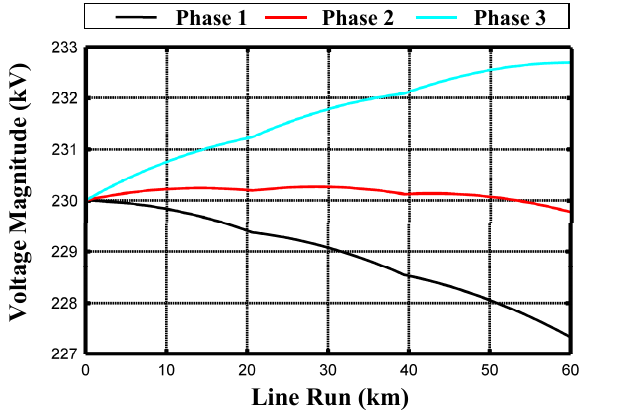
Figure 15. Phase voltage magnitudes along the compensated single-circuit cable in CB without